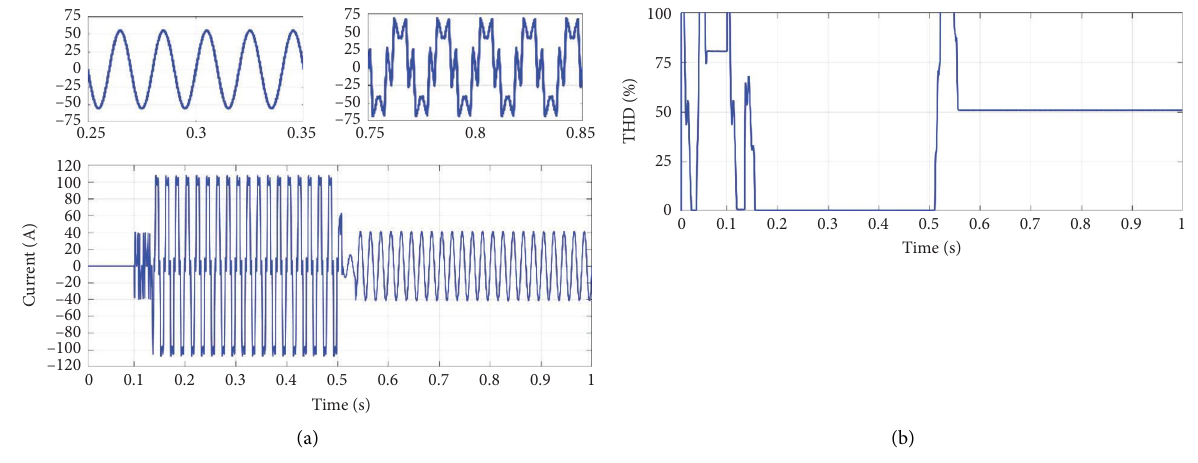
Figure 17: Filter current injected by wind generator (a) and its THD